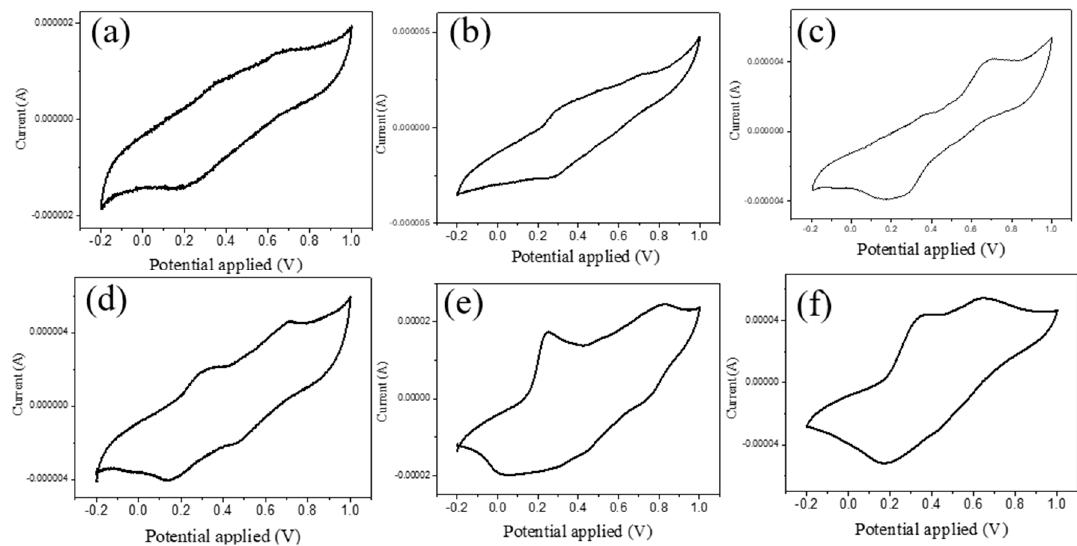
Figure 8. Cyclic voltammetry measurement for SF nanofibers with different added amounts of PANI: